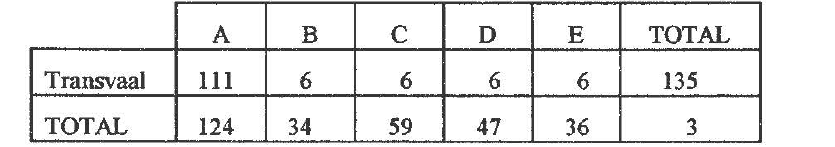
Table 4: Effect on preliminary allocation of an exceptional voting pattern in